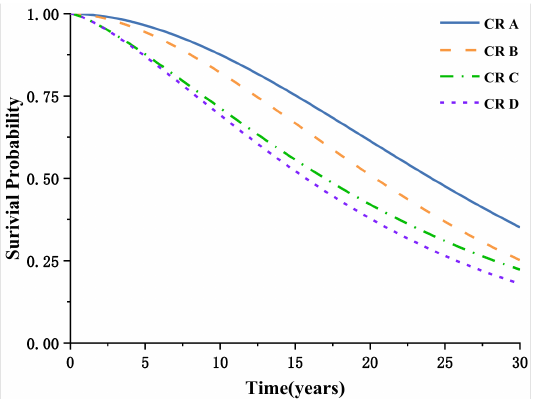
Figure 1. Survival curve of the main girders in each CR.